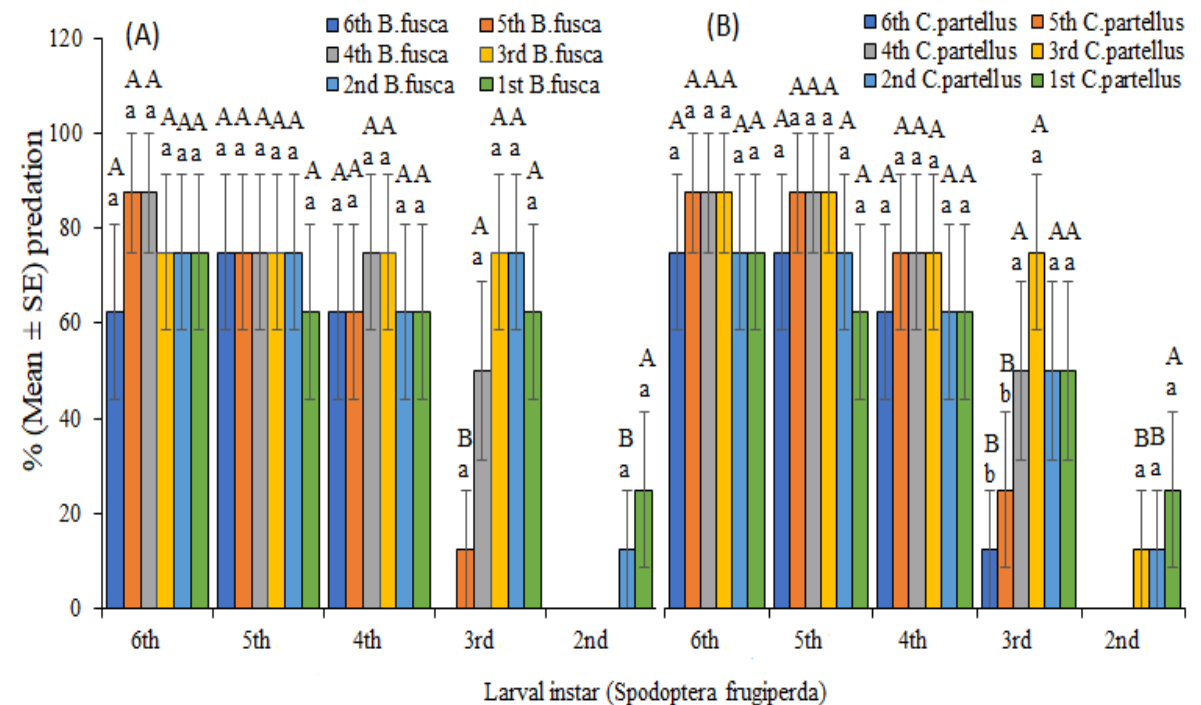
Figure 2. Predation rate (mean ± SE) of different larval instars of Spodoptera frugiperda on ( A ) Busseola fusca and ( B ) Chilo partellus in maize plant experiment after 24 h feeding. Different uppercase letters above the error bars indicate significant differences in the predation rate of given larval instars of Spodoptera frugiperda across larval stages of stemborers, while different lowercase letters above error bars indicate significant differences in the predation rate of each larval development stage of Spodop- tera frugiperda on all stemborer instars.